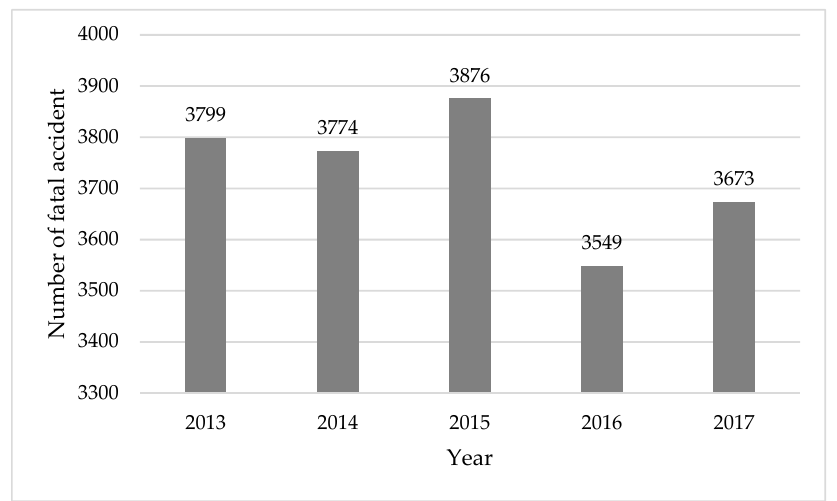
Figure 2. Situation of fatal accidents at the level of the European Union during 2013–2017 [2].